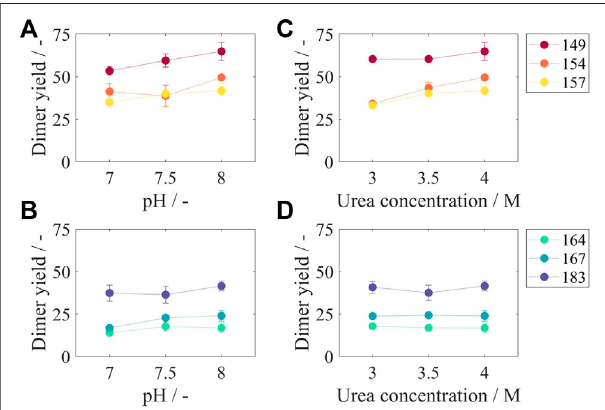
FIGURE 6 | Dimer yields after disassembly reaction for different liquid phase conditions and for all constructs. In sub fi gures (A) and (B) , results for a urea concentration of 4 M and varying pH values are displayed. In sub fi gures (C) and (D) ,resultsforapHofeightandvaryingureaconcentrationscan be found. According to the two-zone behavior, sub fi gures (A) and (C) show results for Cp149, Cp154, and Cp157 and sub fi gures (B) and (D) for Cp164, Cp167, and Cp183, respectively. Results for 3 M urea, 3.5 M urea, pH 7, and pH 7.5 can be found in Supplementary Material S5 . SEC was used to evaluatethedimeryieldafter thedisassembly reaction.Detailsoncapsidpeak identi fi cation can be found in Supplementary Material S2 ; SEC, size- exclusion